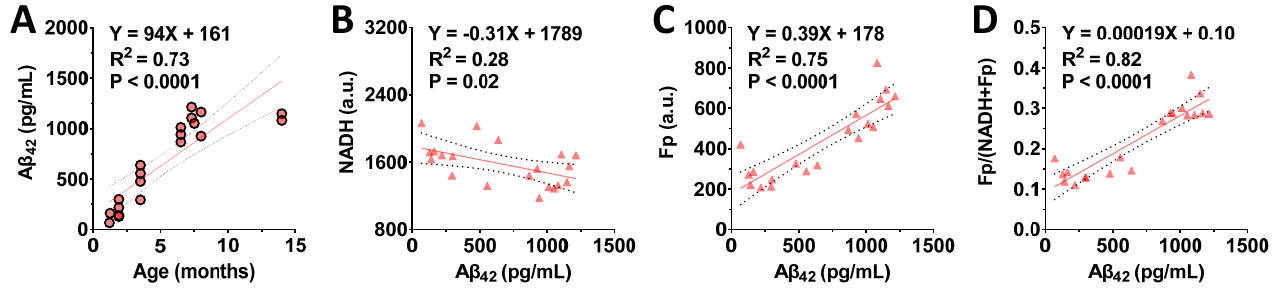
Figure 5. Relationships between A β 42 level (pg/mL) and redox indices in the 5XFAD hippocampi. ( A ) a positive linear correlation between A β 42 level and mouse age; ( B ) a negative linear correlation between NADH and A β 42 ; ( C ) a positive linear correlation between Fp and A β 42 ; ( D ) a positive linear correlation between the redox ratio and A β 42